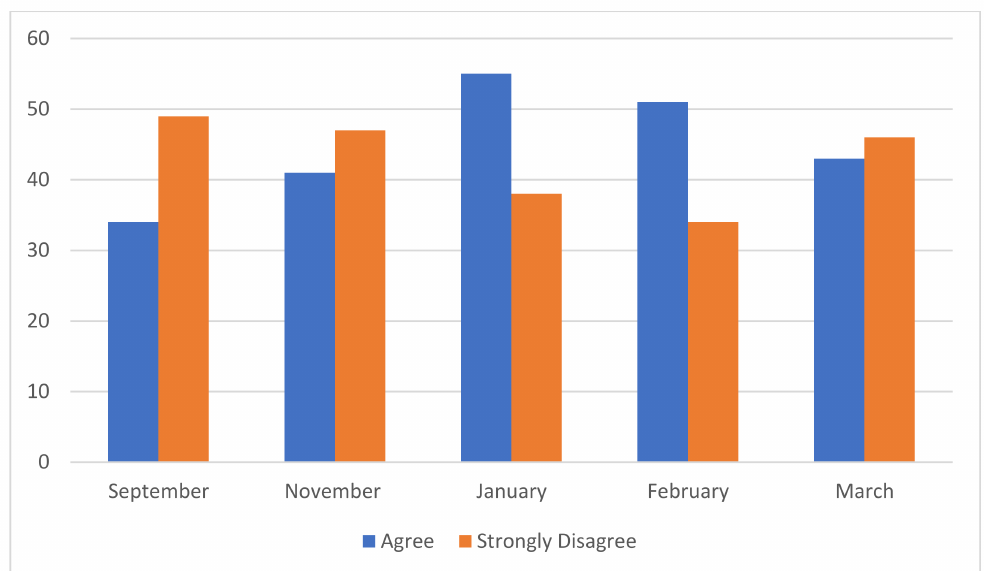
Figure 3. Impact of COVID-19 on carer’s ability to provide support: 5 rating scale to ‘COVID-19 has made it harder for me to provide support for the person with ED’ ( n = 585).